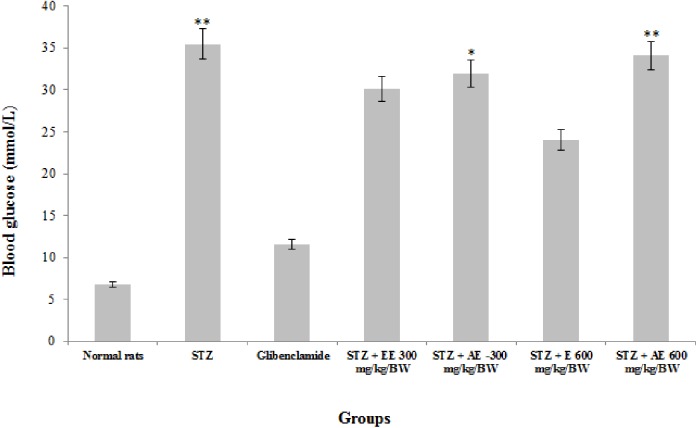
The effect of Ricinus communis leaves extracts on the blood glucose in STZ induced diabetic rats after 2 weeks of treatment.STZ, Control diabetic rats; STZ + EE300 mg/kg/BW, STZ + Ethanol extract at 300 mg/kg/BW; STZ + AE-300 mg/kg/BW, STZ + Aqueous-ethanol at 300 mg/kg/BW; STZ + E600 mg/kg/BW, STZ + Ethanol at 600 mg/kg/BW; STZ + AE600 mg/kg/BW, STZ + Aqueous-ethanol at 600 mg/kg/BW. *Values are statistically significant at p < 0.05. **Values are statistically significant at p < 0.01. The data were analysed using the parametric method, ANOVA followed by Tukey’s post-hoc test.